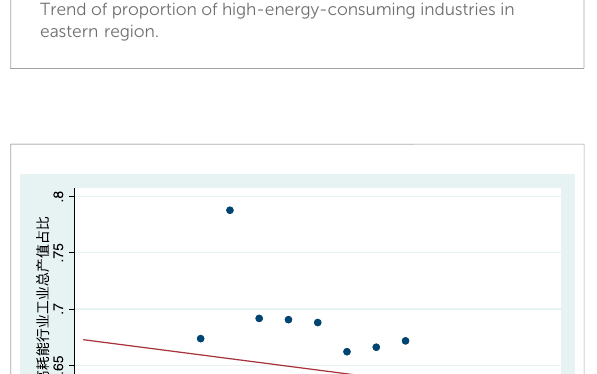
FIGURE 1 Trend of proportion of high-energy-consuming industries in eastern region.